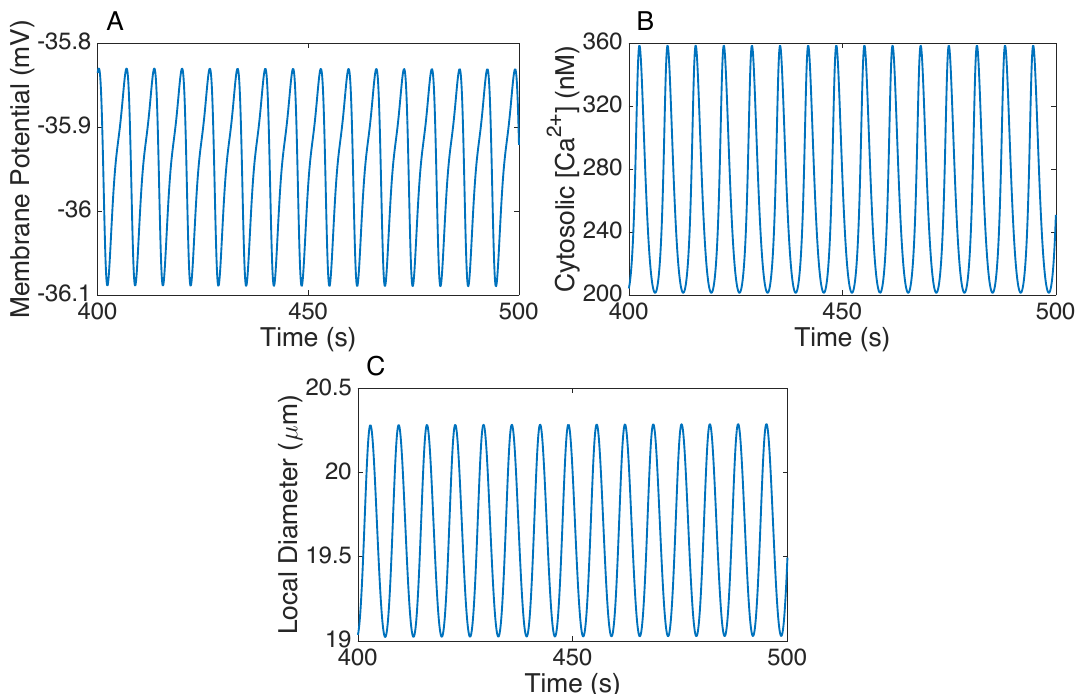
Figure 4. Predicted oscillations for the first cell in the afferent arteriole at an inflow pressure of 100 mmHg for the ( A ) membrane potential; ( B ) cytosolic concentration of Ca 2 + ; and ( C ) afferent arteriole local diameter.